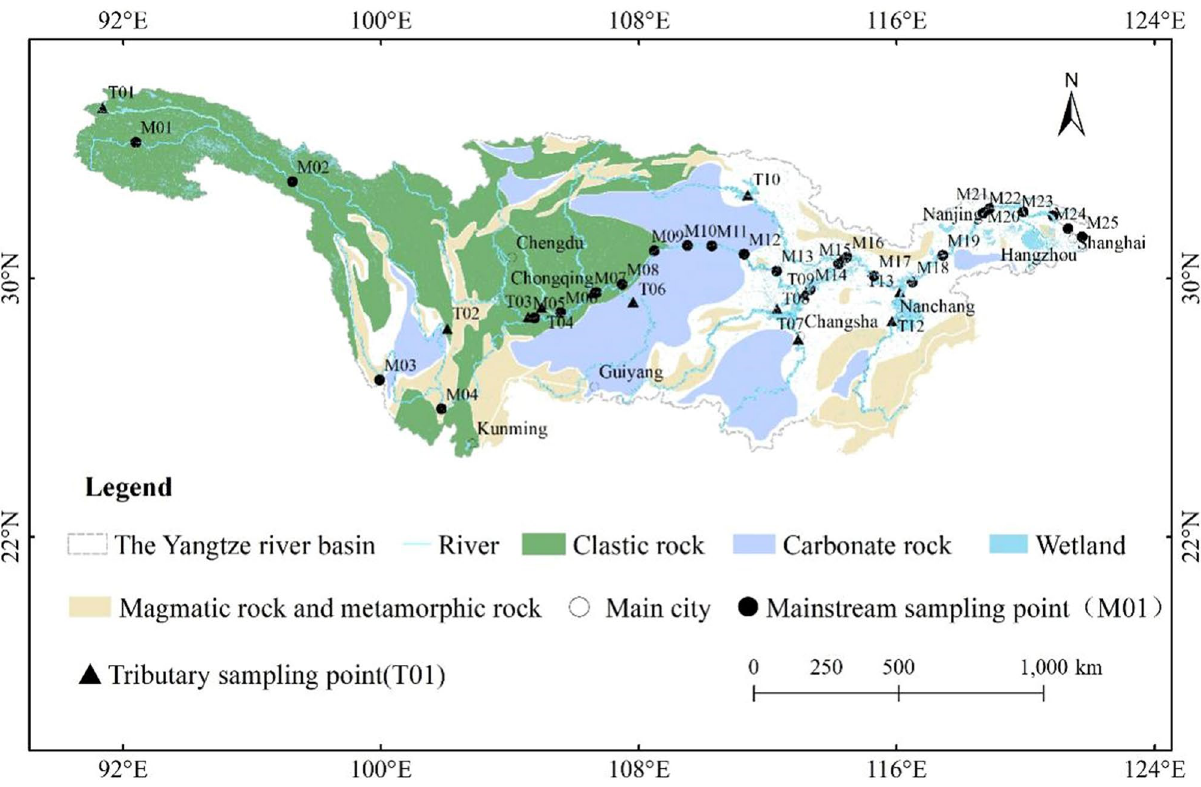
Figure 1. The map of Yangtze River Basin and the sampling points (Cited from Ding et al. 12 ). Note : The sketch of geological map in the study region was redigitized from Ding’s publication using ARCGIS 10.4 (www. esri. com/ en- us/ store/ overv